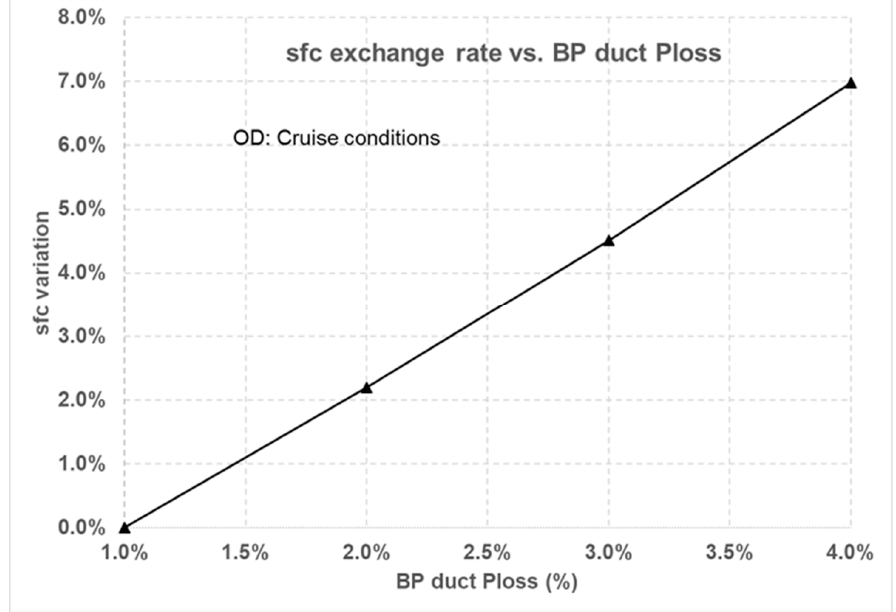
Figure 15. Effect of bypass duct pressure loss. Figure 15. E ff ect of bypass duct pressure loss. Appl. Sci. 2020 , 10 , x FOR PEER REVIEW